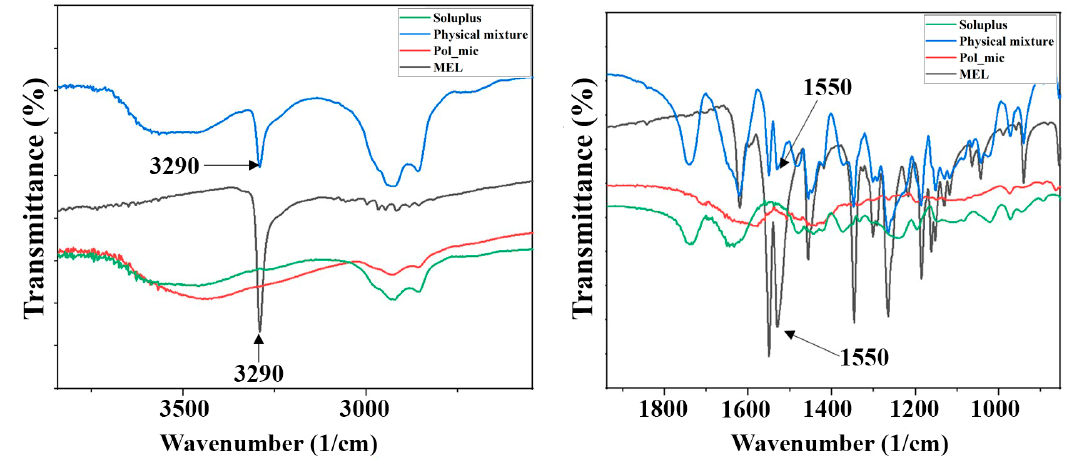
Figure 7. FT-IR spectra of the enlarged regions indicating the secondary interactions.